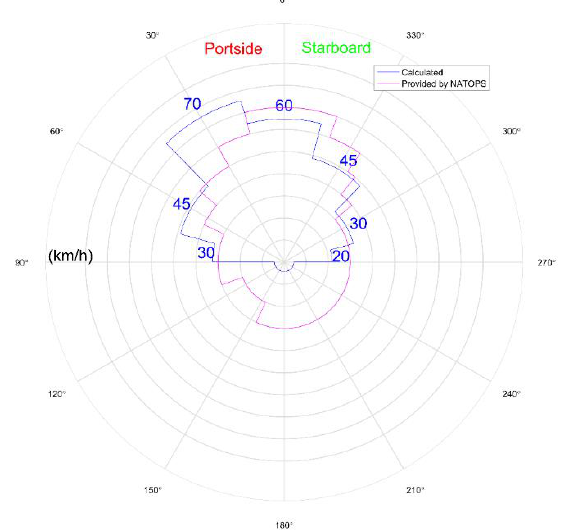
Figure 22. Calculated SHOL envelope of CG47 with UH60 helicopter.